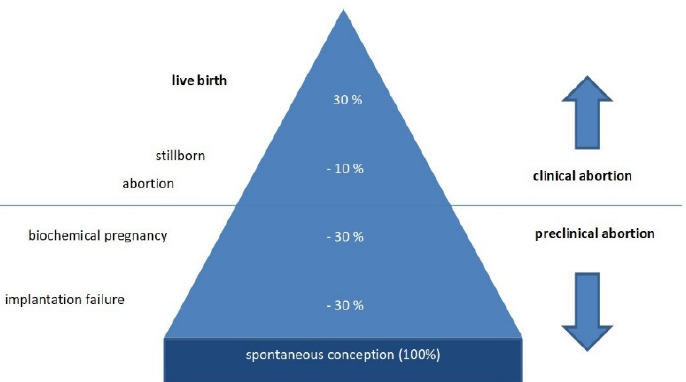
Figure 1. Human reproduction is an inefficient process. Only about 30% of conceptions (100%) result in a live birth. (modified according to [3]).